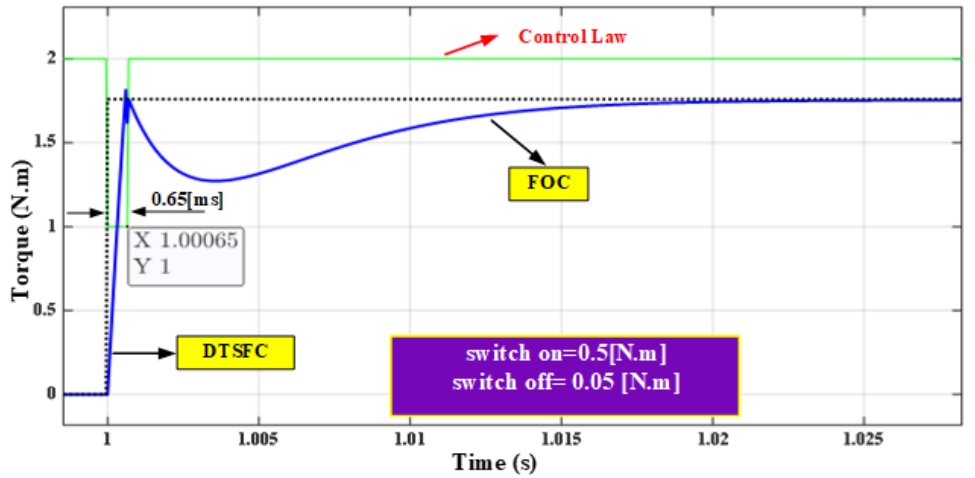
Figure 28. Torque response in the proposed combined FOC-DTC with different values of switch-on and